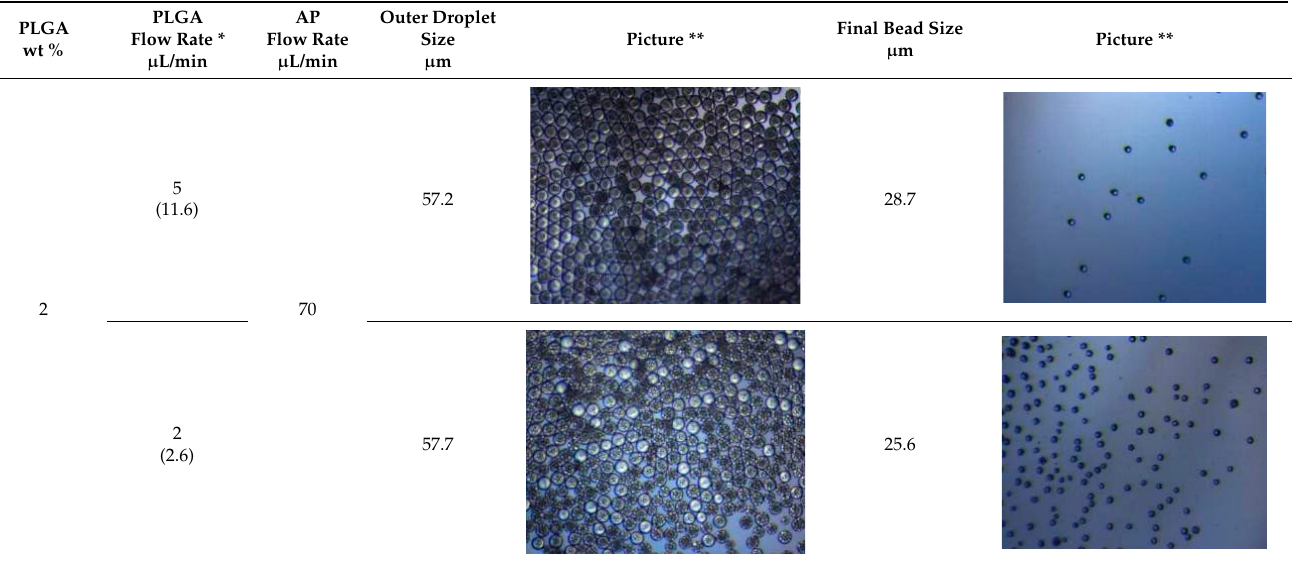
Table 2. Flow/MP size/polymer concentration relationship. (https://microtas2020.org/images/cur- rent_support_files/dolomite/Dolomite_Application_Note-Microfluidic_Produc-